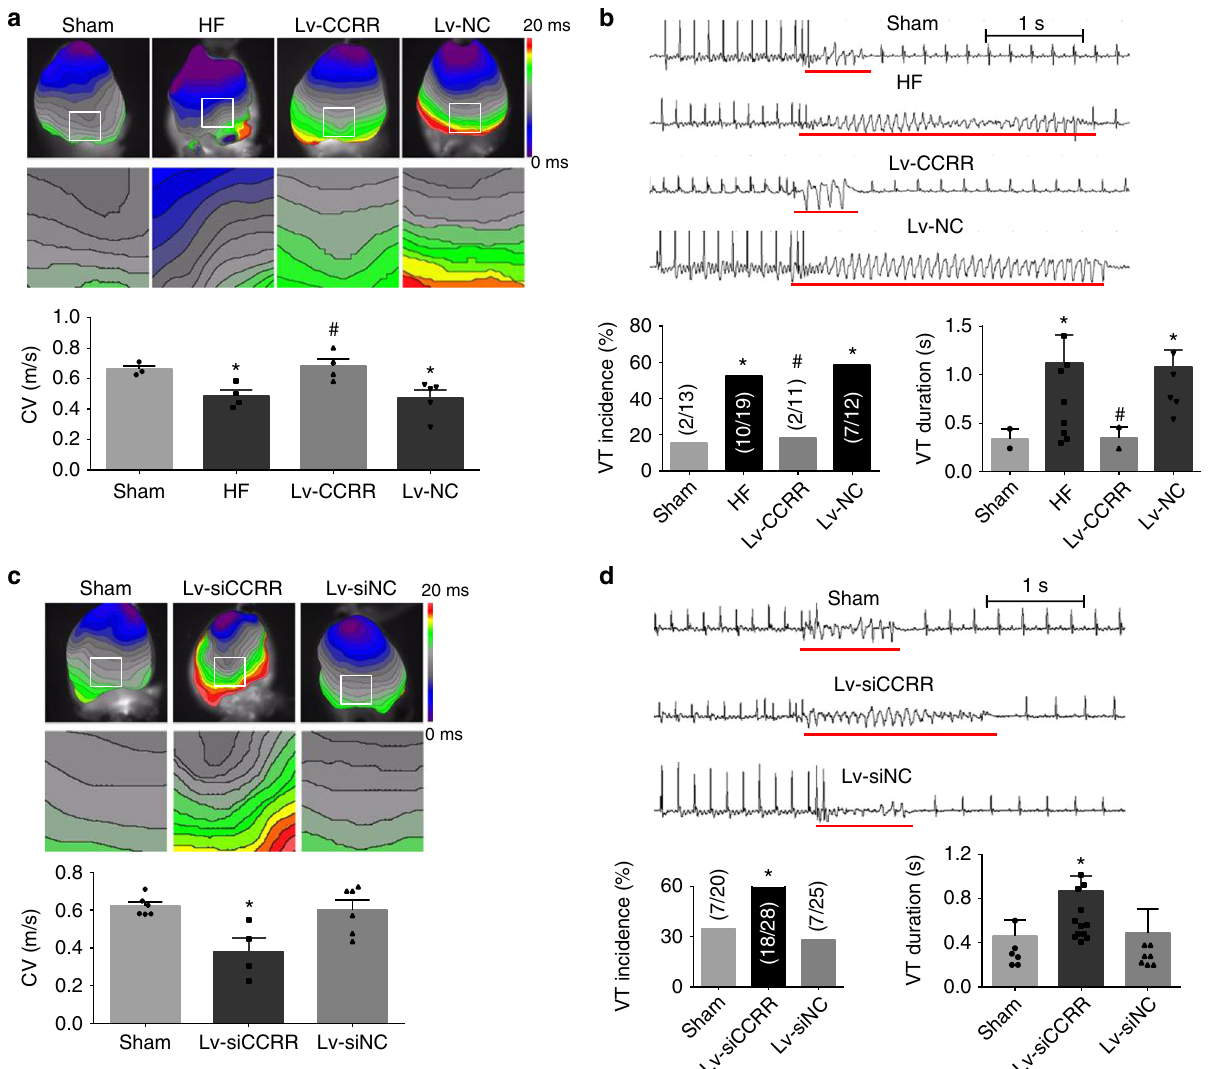
Fig. 2 Regulation of cardiac conduction and arrhythmias by CCRR in HF mice. a Slowing of conduction velocity (CV) in HF and restoration by CCRR overexpression. CV was determined by optical mapping techniques with a voltage-sensitive dye to de fi ne the cardiac activation. CV values were calculated from the gradient of the scalar fi eld of 12-ms isochronal activation maps along the septal apex – base axis: CV = distance/12ms. Note that CV was substantially decreased in HF and this conduction slowing was restored in the hearts pretreated with the lentivirus carrying the CCRR gene for overexpression (Lv-CCRR), but not with the negative control construct (Lv-NC). Viral vectors were administered by intracavity injection (directly injected into the left ventricular chamber). The Sham group underwent the same surgical procedures without TAC. * P < 0.05 HF or Lv-NC vs. Sham-control; # P < 0.05 Lv-CCRR vs. HF; n = 4 mice for each group. b Antiarrhythmic effects of CCRR overexpression in a mouse model of HF. The incidence and duration of ventricular tachycardia (VT) induced by programmed stimuli were determined from ECG recordings. Note that the arrhythmogenicity was signi fi cantly enhanced in HF hearts, which was considerably suppressed by Lv-CCRR, but not by Lv-NC. The red lines in the ECG traces indicate VT duration, and the values within the parentheses in the bar charts indicate VT incidence. * P < 0.05 HF or Lv-NC vs . Sham-control; # P < 0.05 Lv-CCRR vs. HF. c Slowing of cardiac conduction induced by CCRR knockdown in healthy mice. The lentivirus vector engineered to contain a CCRR siRNA (Lv-siCCRR) was injected into the left ventricular chamber to silence myocardial CCRR. Lv-siCCRR caused a remarkable decrease in cardiac CV, whereas the negative control (Lv-siNC) failed to elicit any signi fi cant changes. The Sham group received the same surgical procedures without injecting vectors. * P < 0.05 Lv-siCCRR vs. Sham- Control; n = 4 mice for each group. d Pro-arrhythmic effects of CCRR knockdown in healthy mice. A prominent fi nding here is that knockdown